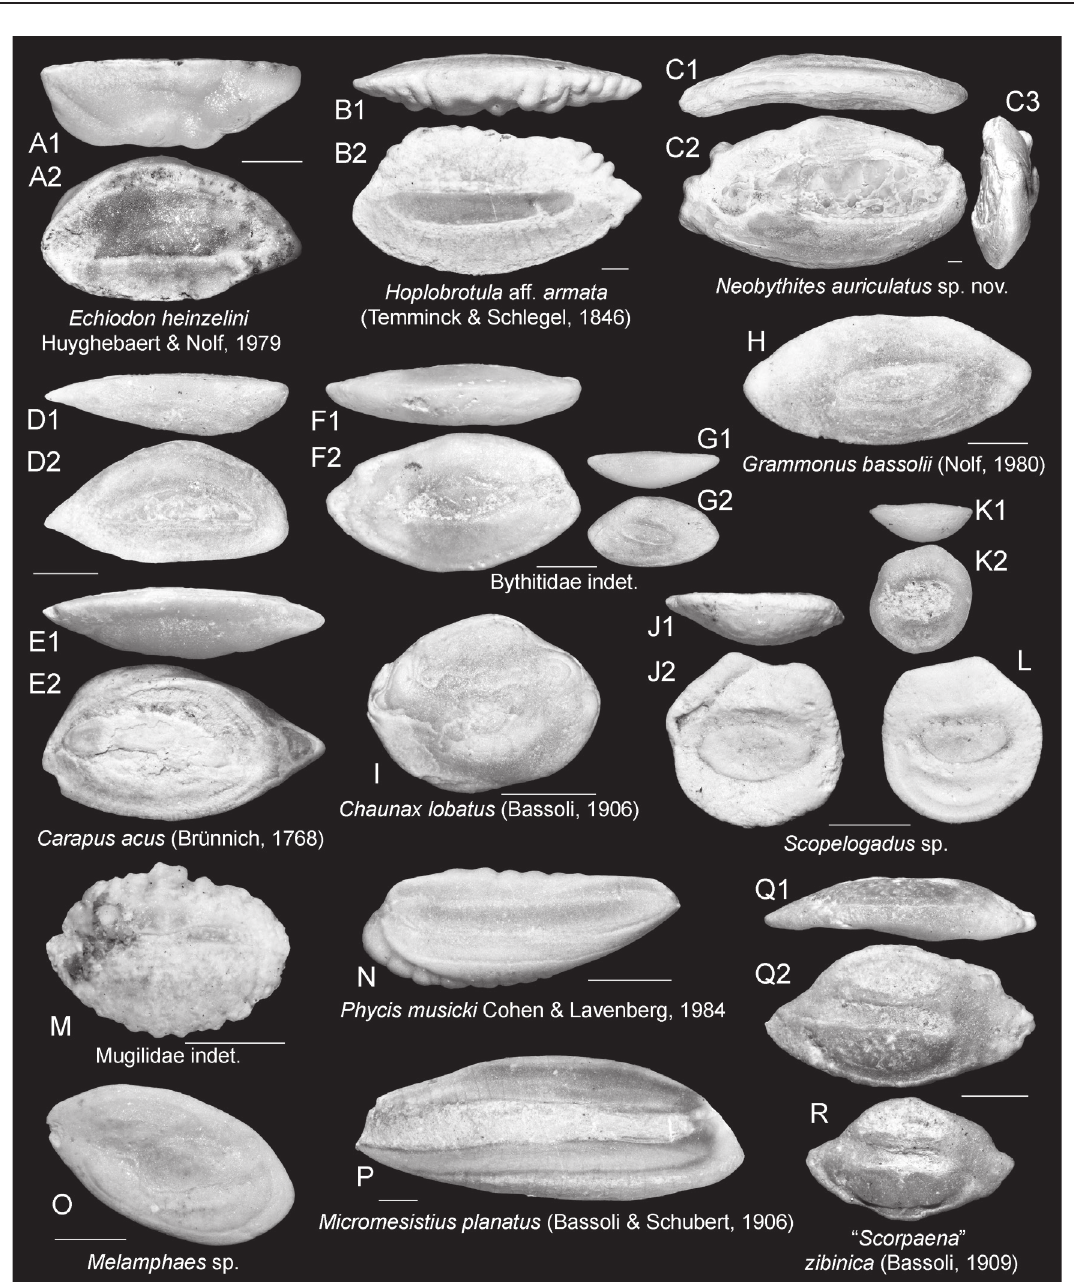
Fig. 9. Tortonian fish otoliths from northern Italy. A . Echiodon heinzelini Huyghebaert & Nolf, 1979, Torrente Stirone (IRSNB P 9787). B . Hoplobrotula aff. armata (Temminck & Schlegel, 1846), Sant’Alosio (IRSNB P 9788). C . Neobythites auriculatus sp. nov., Sant’Alosio (IRSNB P 9688 (holotype). D–E . Carapus acus (Brünnich, 1768); D . Torrente Stirone, E . Sant’Agata Fossili (IRSNB P 9789–P 9790). F–G . Bythitidae indet., Torrente Stirone (IRSNB P 9791–P 9792). H . Grammonus bassolii (Nolf, 1980), Torrente Stirone (IRSNB P 9793). I . Chaunax lobatus (Bassoli, 1906), Montegibbio (IRSNB P 9794). J–L . Scopelogadus sp.; J . Alba, Tanaro (5 m), K . Stazzano, L . Alba, Tanaro (50 m) (IRSNB P 9795–P 9797). M . Mugilidae indet., Sant’Alosio (IRSNB P 9798). N . Phycis musicki Cohen & Lavenberg, 1984, Torrente Stirone (IRSNB P 9799). O . Melamphaes sp., Alba, Tanaro (50 m) (IRSNB P 9802). P . Micromesistius planatus (Bassoli & Schubert, 1906), Montegibbio (IRSNB P 9803). Q–R . “ Scorpaena ” zibinica (Bassoli, 1909), Torrente Stirone (IRSNB P 9800–P 9801). 1 = ventral view; 2 = inner view; 3 = anterior view. Scale bars = 1